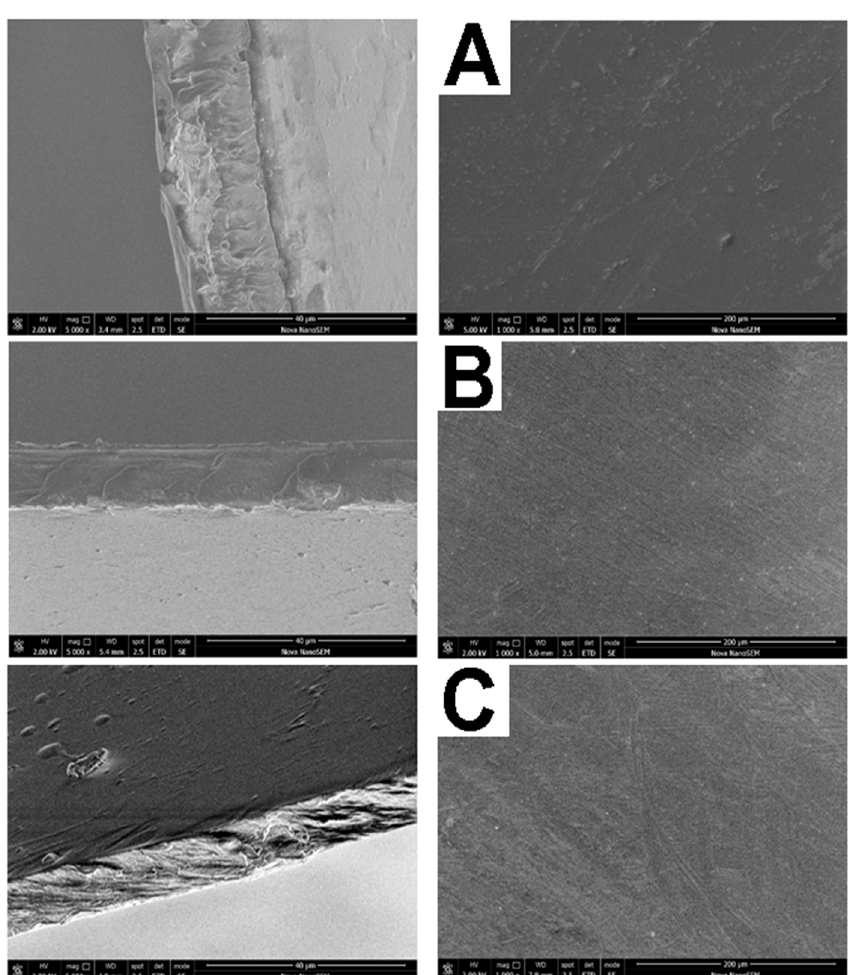
Figure 2. Cross section and surface SEM images of the Bioartificial polymeric systems (BAPS): ( A ) PVA/ADD/AMP. ( B ) CHI/ADD/AMP. ( C ) PVA/CHI/ADD/AMP.